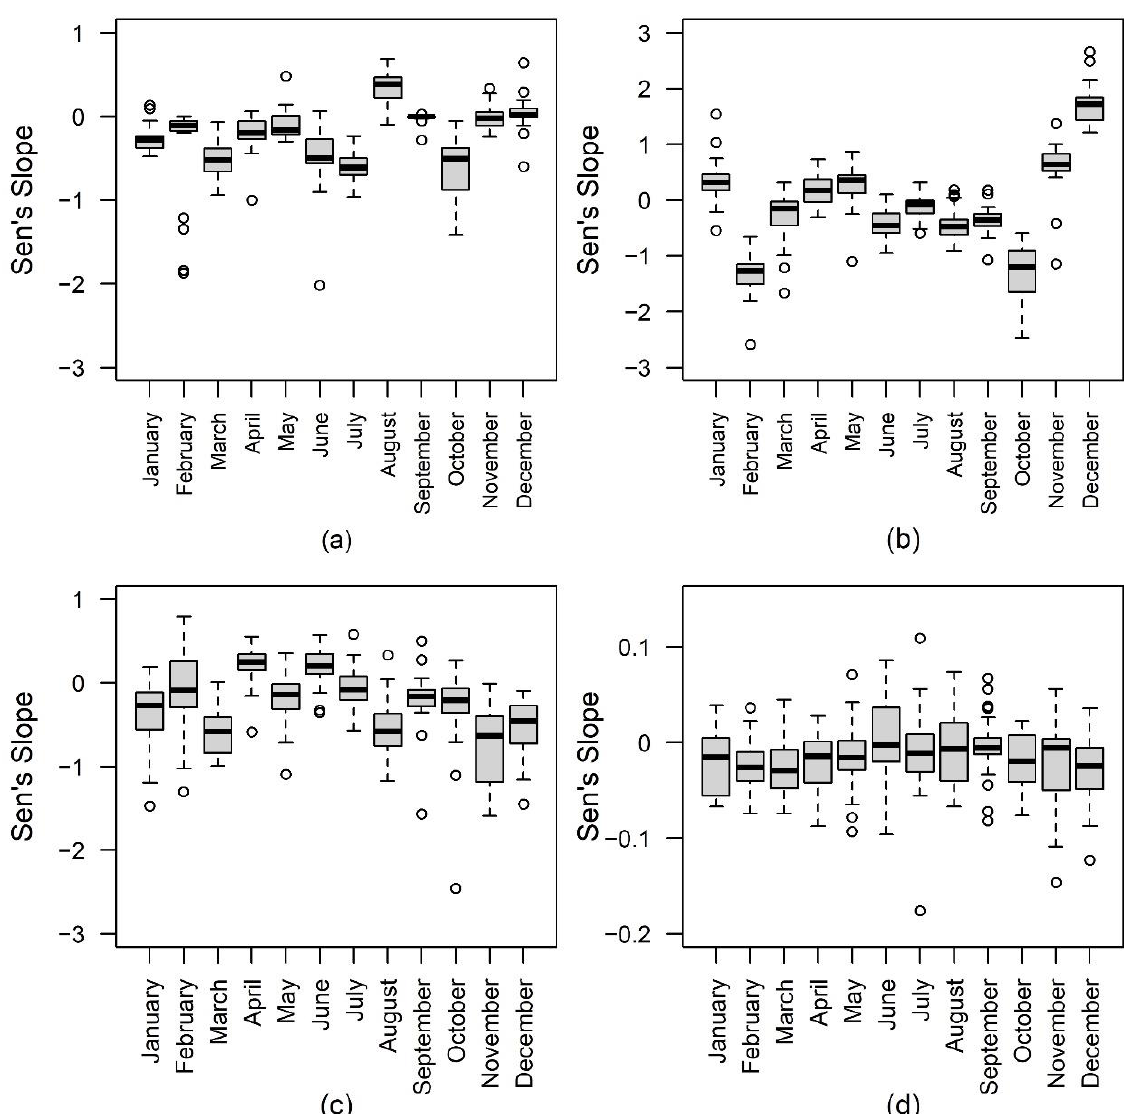
Figure 3. The boxplot of the Sen’s slopes: ( a ) the maximum temperature; ( b ) the minimum temperature; ( c ) the maximum wind speed; and ( d ) the minimum wind speed of each month.